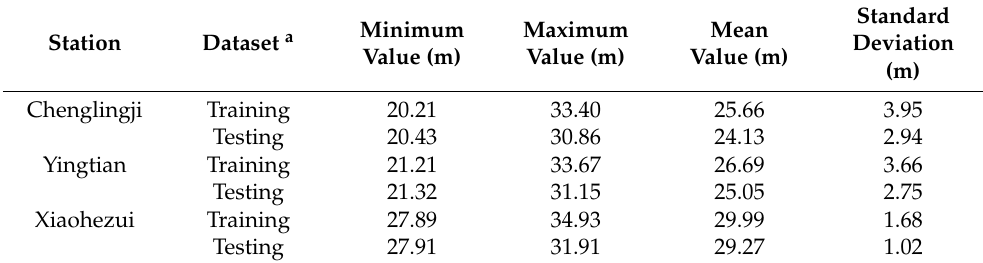
Table 1. Statistical characteristics of Dongting Lake water levels.